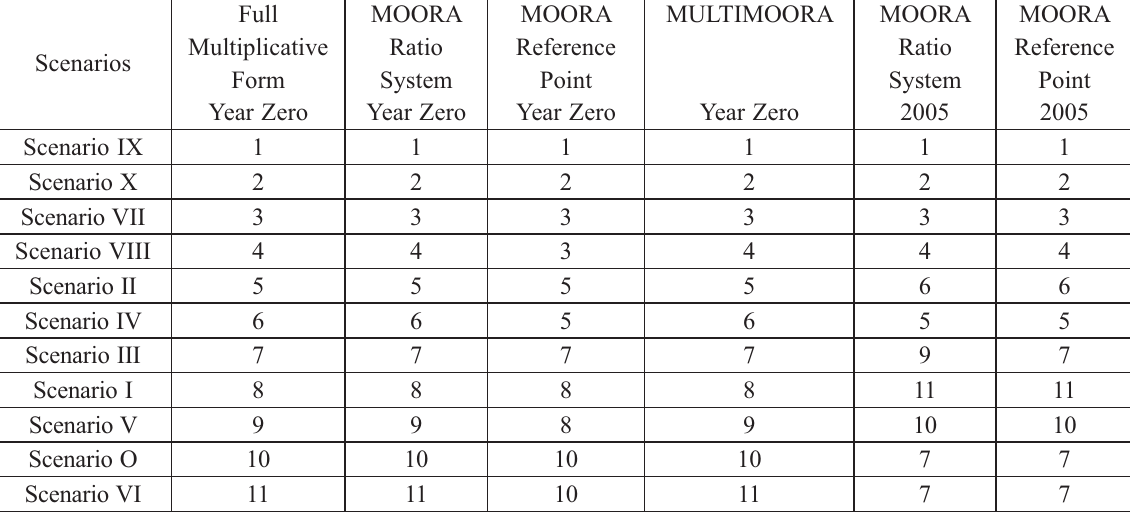
Table 6. Ranking the Belgian Regions by